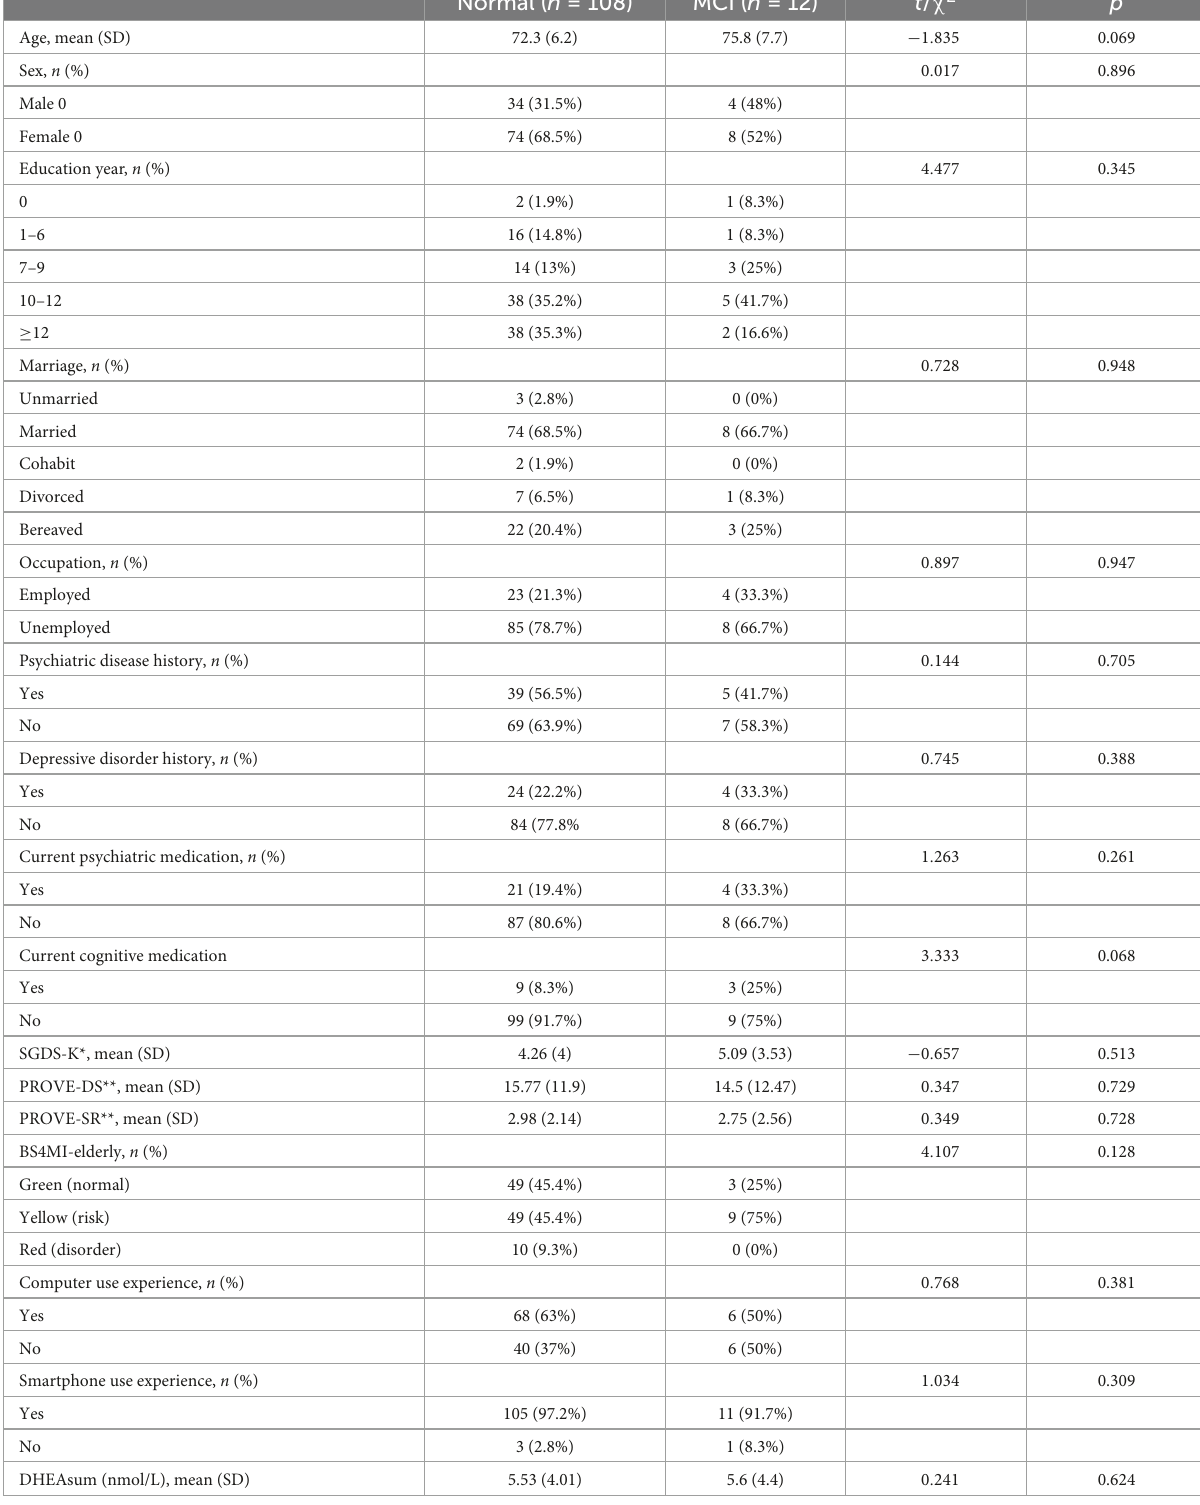
TABLE 1 Demographic and clinical characteristics of normal and MCI